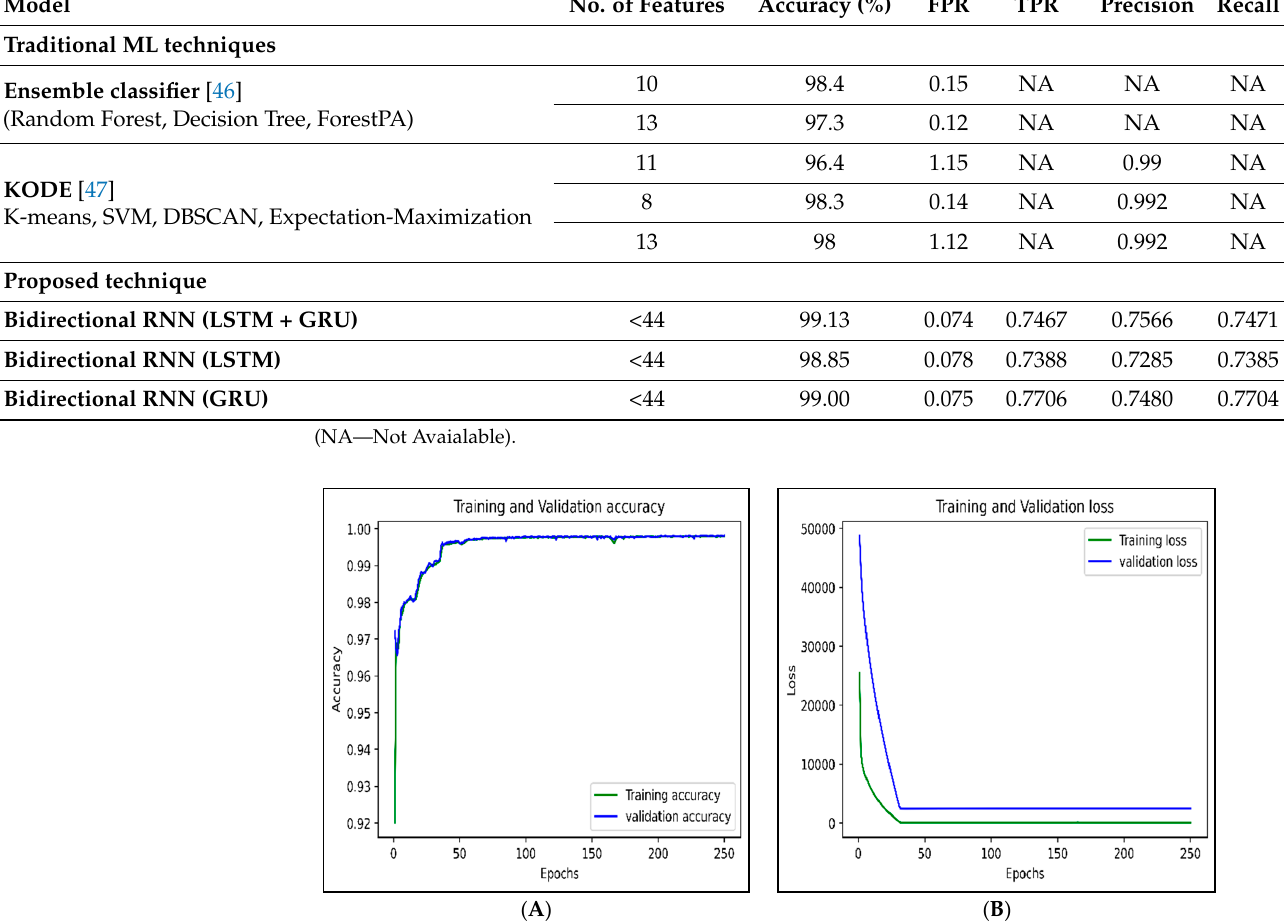
Table 13. Performance comparison (traditional vs. proposed model).